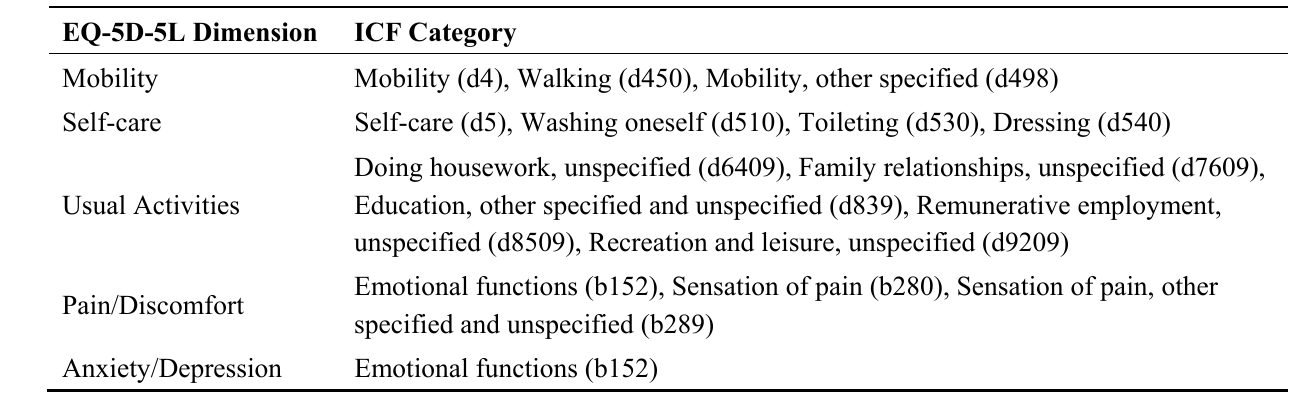
Table 6. Mapping of ICF categories into EQ-5D-5L